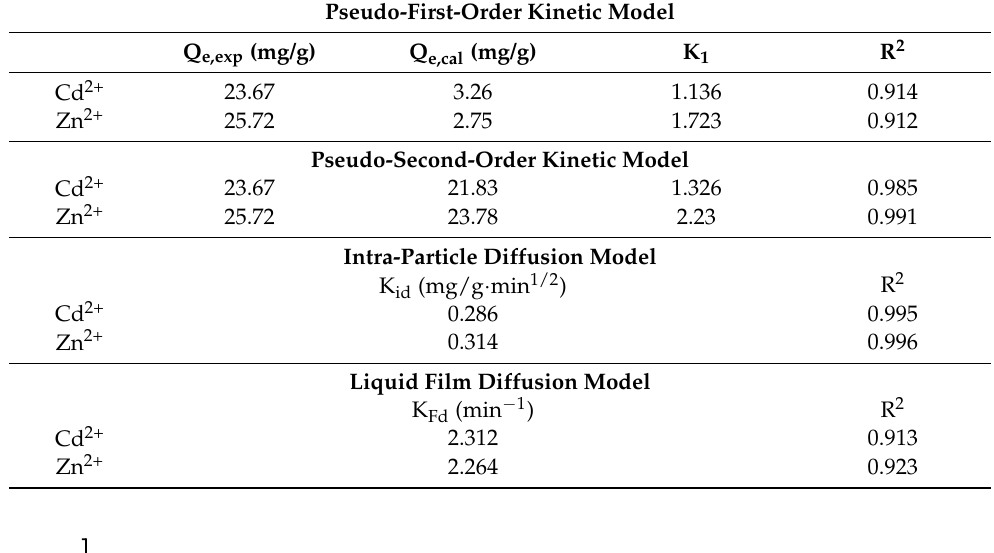
Table 4. Different kinetic model parameters for the composite based of HAp/CTs.